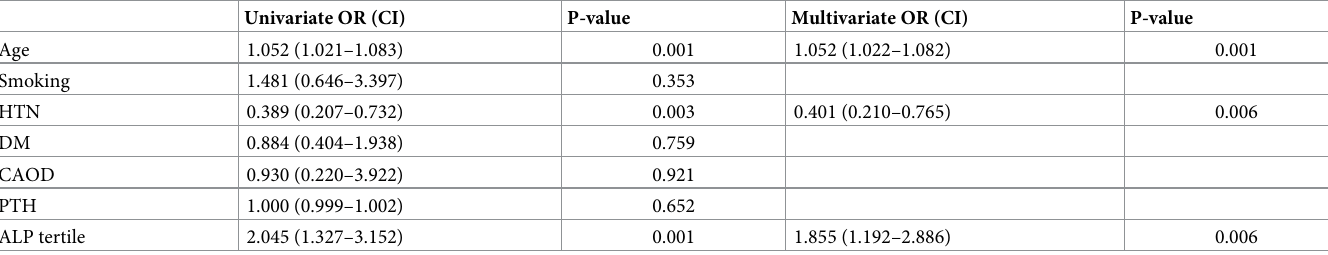
Table 3. Logistic regression analysis for predictors of 3-year mortality of patients after kidney transplantation. Univariate OR (CI)